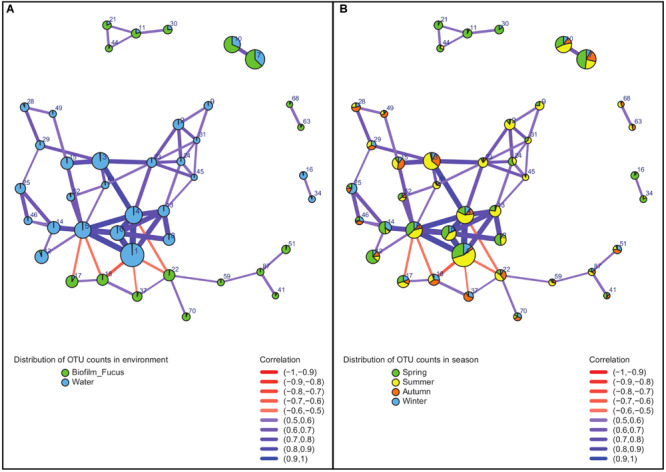
Association network of strongly correlated OTUs. Analysis was performed on sequence data of entire dataset. Vertices represent OTUs and are labeled by OTU number (for details see Supplementary Table S2) and colored according to (A) distribution in environment (habitat) or (B) distribution in season, respectively. Width and color of the edges connecting the vertices vary according to strength and sign (color gradient red to blue describes negative to positive) of the correlation between associated OTUs. Diameters of the vertices vary according to the relative abundance of each OTU.